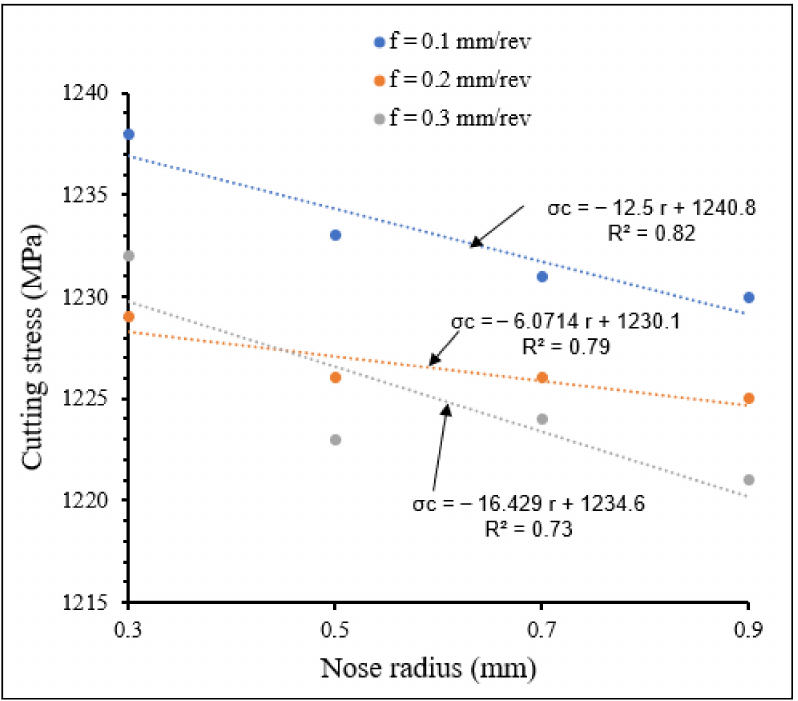
Figure 15. Variation of cutting stress with large tool nose radius at different feed rates. V = 104 m/min, γ =